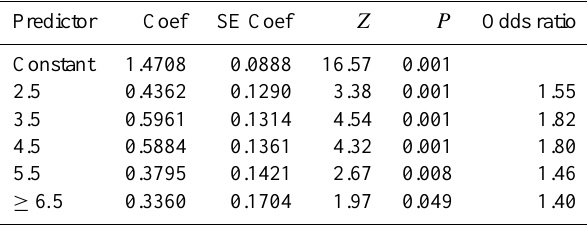
Table 6. Reproductive performance of Central Anatolian Merino ewes and survival rates of lambs by premating age of the ewes. Traits 1.5 2.5 Overall Ewes that were exposed 835 1013 1068 937 692 390 4935 Ewes that lambed 679 882 Ewes with single lamb 533 Ewes with multiple lambs 146 Number of lambs born 825 Fertility rate 1 , % Multiple birth rates 2 , % Survival rate up to 120th day, %